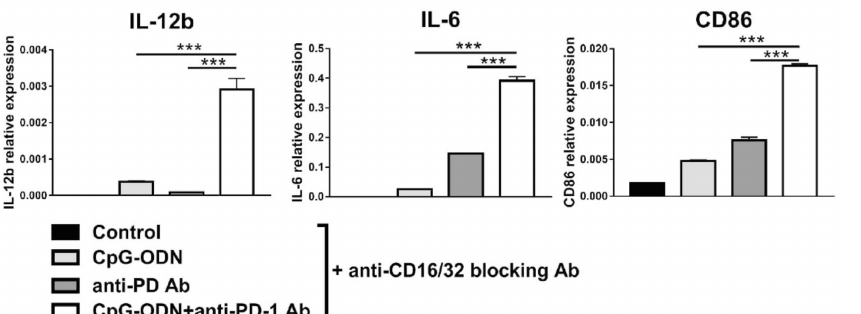
Figure 7. Influence of blocking Fc γ R2b (CD32) and Fc γ R3 (CD16) on the effect of the combination of CpG-ODN and an anti-mouse PD-1 antibody on RAW264.7 macrophages in vitro. RAW264.7 macrophages were seeded in 12-well plates and then pretreated for 30 min with 10 µ g/mL rat anti-mouse CD16/32 blocking antibody. Subsequently, the cells were stimulated with 1 µ M CpG- ODN and 10 µ g/mL anti-mouse PD-1 antibody alone or in combination for 6 h. Controls were left untreated. At the end of treatment, mRNA was extracted, and real-time PCR was performed. The data were normalized to the expression of β 2m as a housekeeping reference gene and analyzed by the comparative 2 − ∆ Ct method. The data are presented as the mean ± SEM. *** p < 0.001 by one-way ANOVA followed by Tukey’s multiple comparison test with a single pooled variance or by the Kruskal–Wallis test followed by Dunn’s multiple comparison test for nonparametric data.